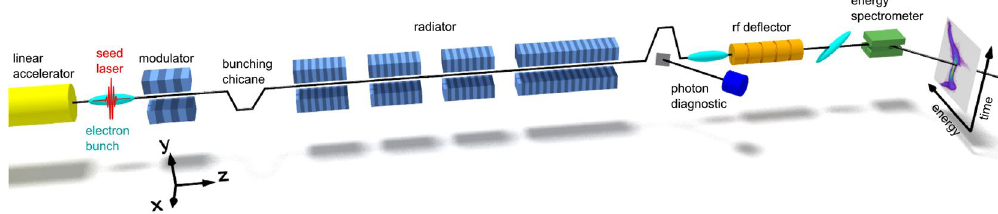
Figure 1. Schematic view of the sFLASH setup. The electron bunch traverses the beamline from left to right coming from the linear accelerator at a kinetic energy of 685 MeV. It is energy modulated at the seed laser wavelength 266 nm in the first long-period undulator. The subsequent chicane transforms the induced energy modulation into a current modulation. In the following undulator modules (radiator) these coherent structures initiate the FEL process at a harmonic of the seed laser wavelength. The electron bunches are characterized with an rf deflector followed by an energy spectrometer, which enables access to the longitudinal phase-space distribution by means of a diagnostic screen